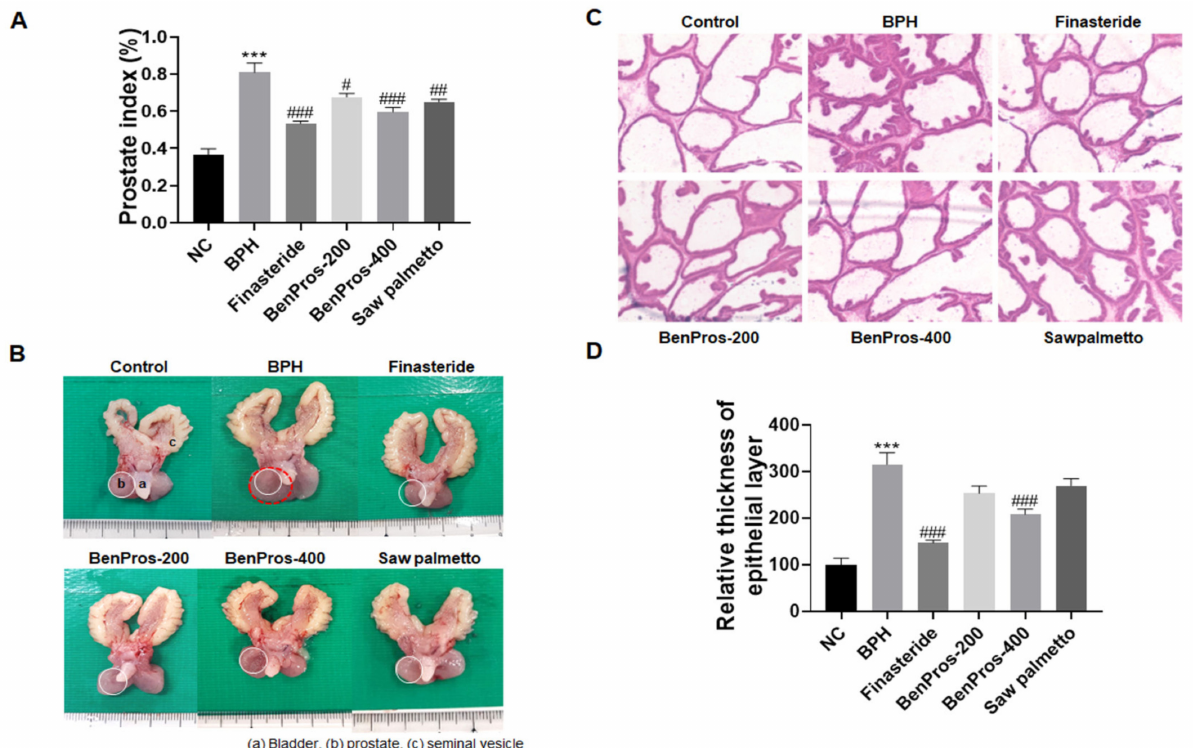
Figure 5. Histopathological analysis of BPH rats. ( A ) The changes in the rat prostate index. ( B ) Rep- resentative photomicrographs (ventral prostatic lobes, seminal vesicles, and bladder) of the dissected prostate. ( C ) Representative histological results based on hematoxylin and eosin staining in prostate tissues (magnification, × 200). ( D ) The epithelial thickness of prostate tissues. The data are presented as the mean ± standard error of the mean of 6 rats per group. *** p < 0.001 vs. NC; # p < 0.05, ## p < 0.01 and ### p < 0.001 vs.